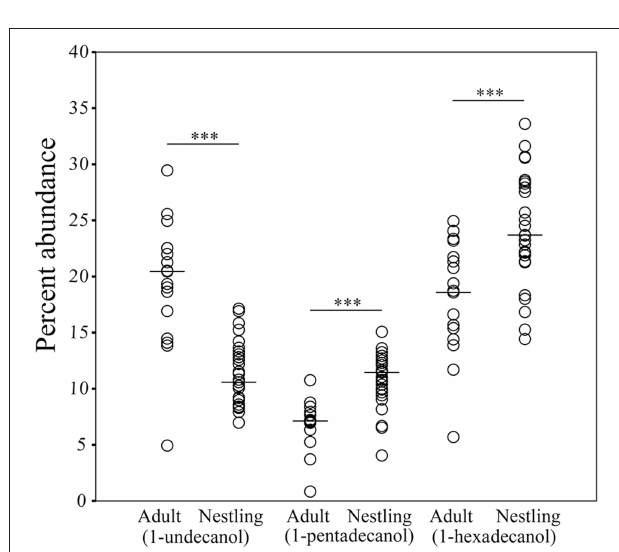
FIGURE 7 | Comparisons of differences in the percent abundance of 1-undecanol, 1-pentadecanol, and 1-hexadecanol in the volatile profiles of adult and nestling uropygial gland oils (*** p ≤ 0.001). Lines indicate median values.